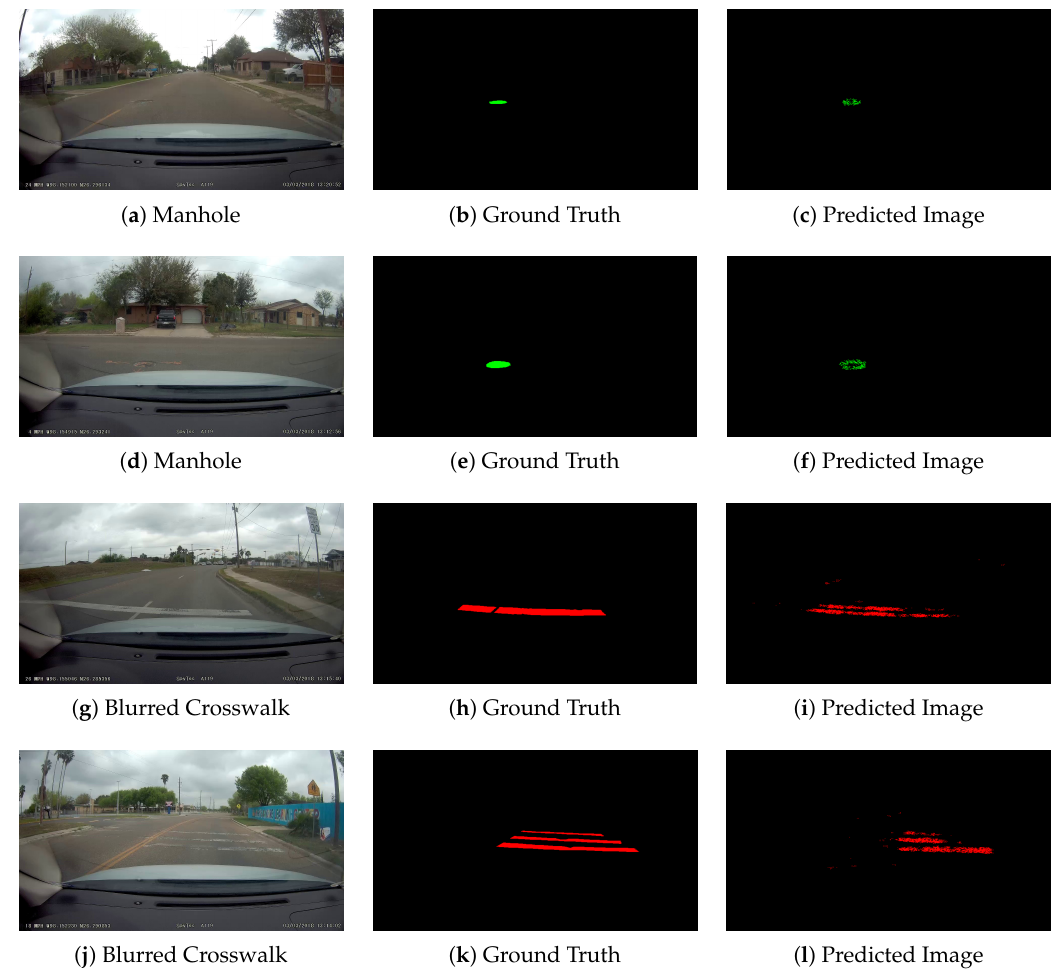
Figure 9. Semantic segmentation examples on FC-DenseNet 130